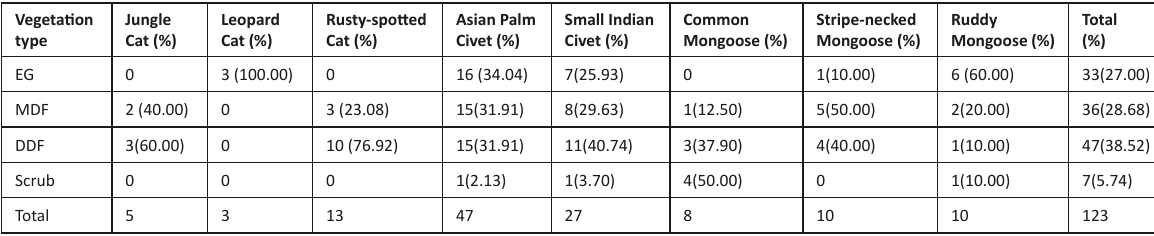
Table 2. Proportion of detections in different vegetation type in BRT Vegetation